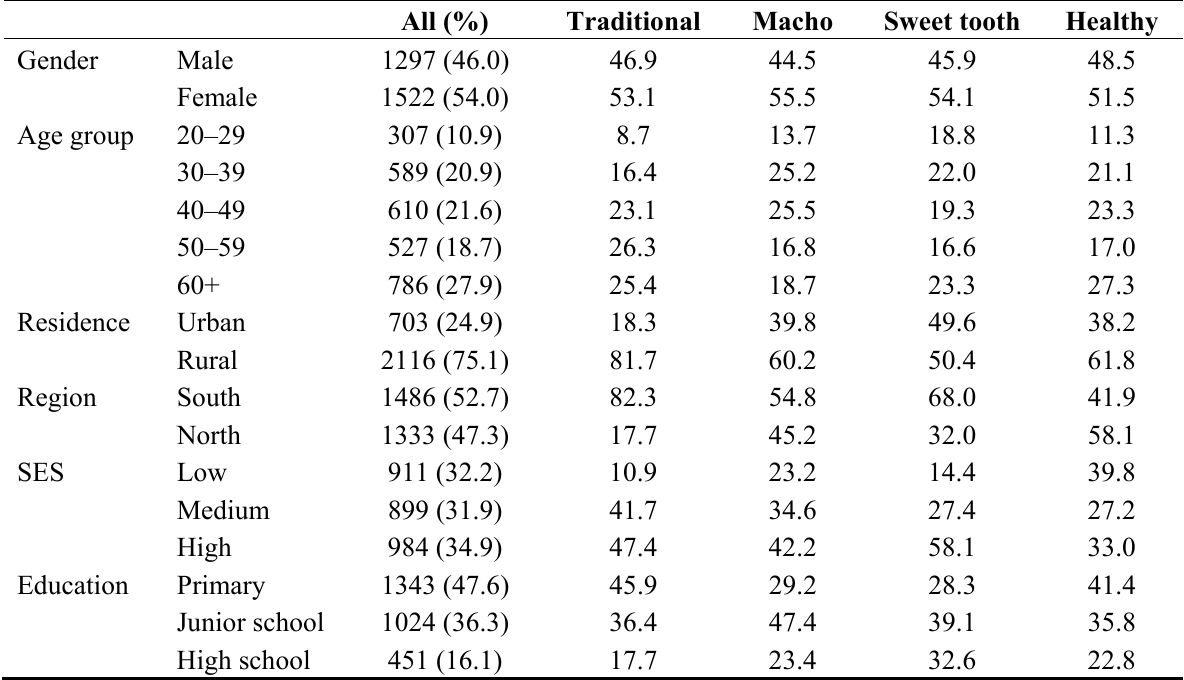
Table 2. Sample characteristics in the highest quartile of dietary patterns. All